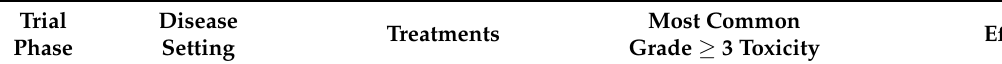
Table 5. Clinical trials of WEE1